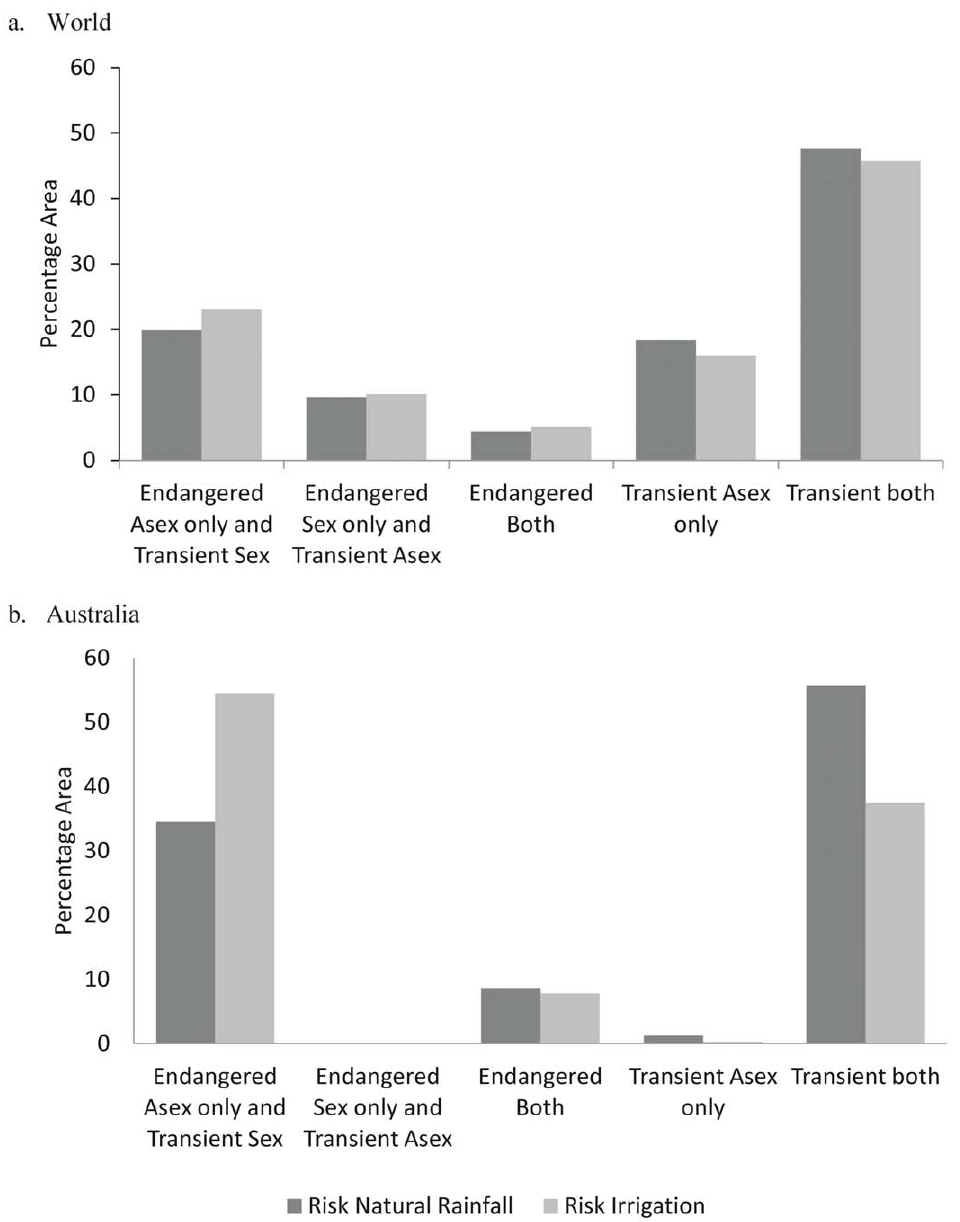
Figure 5. Proportion of area occupied by each Rhopalosiphumpadi risk category. The data for the world (a), and Australia only (b), is generated from two CLIMEX models. The models illustrate the asexual and sexual modes of reproduction of the species, the presence or absence of the primary host plant and scenarios incorporating natural rainfall or irrigation. The ‘potentially endangered sexual only and transient asexual’ risk category is not shown here.